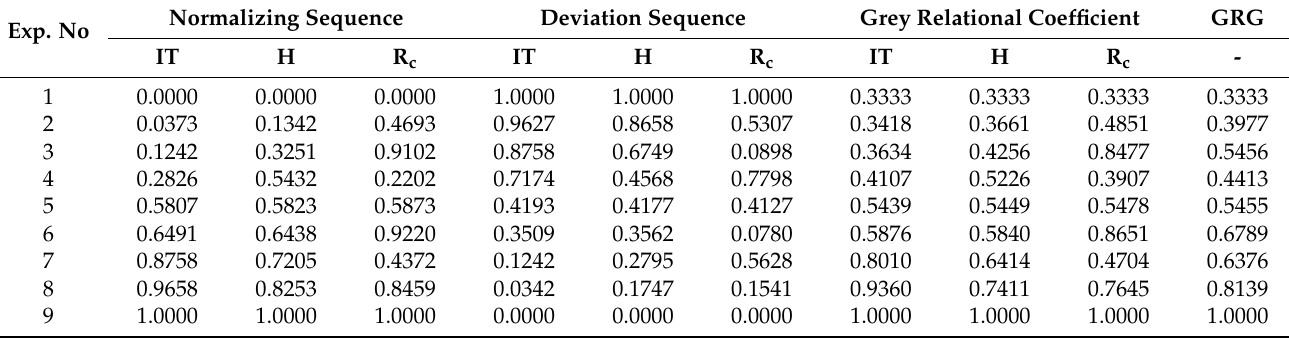
Table 6. Normalizing sequence and deviation sequence.